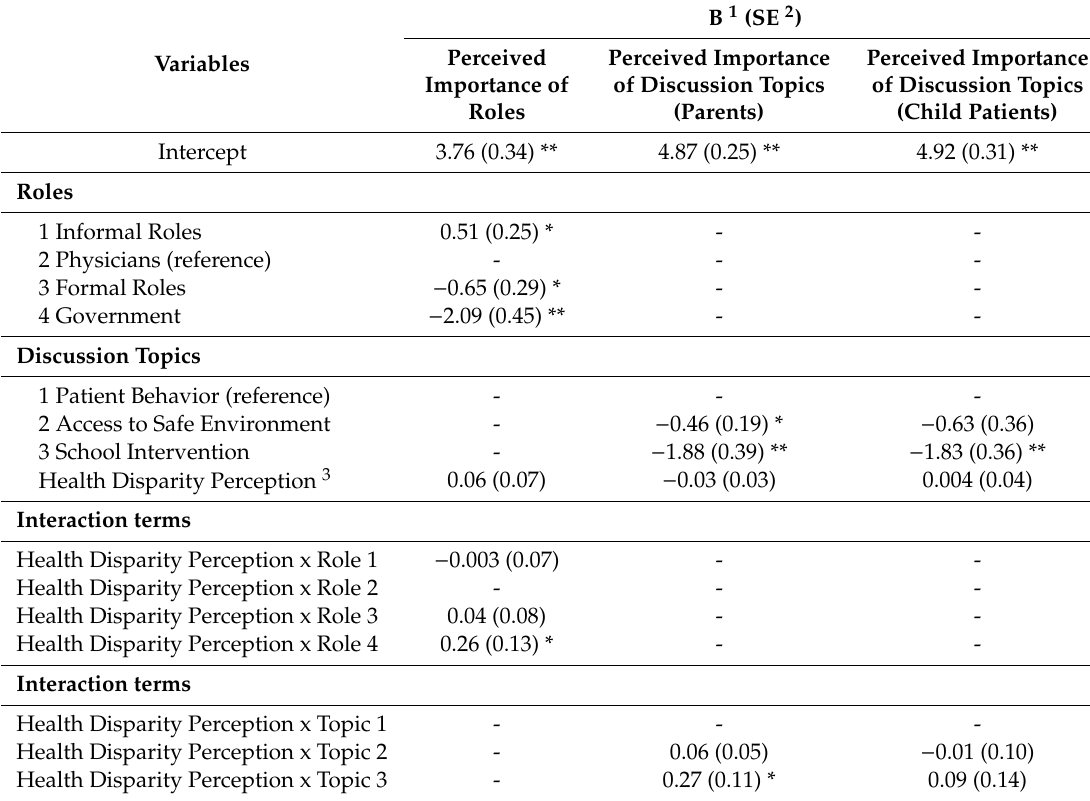
Table 3. Regression model for interaction between health disparity perception and different roles or discussion topics.